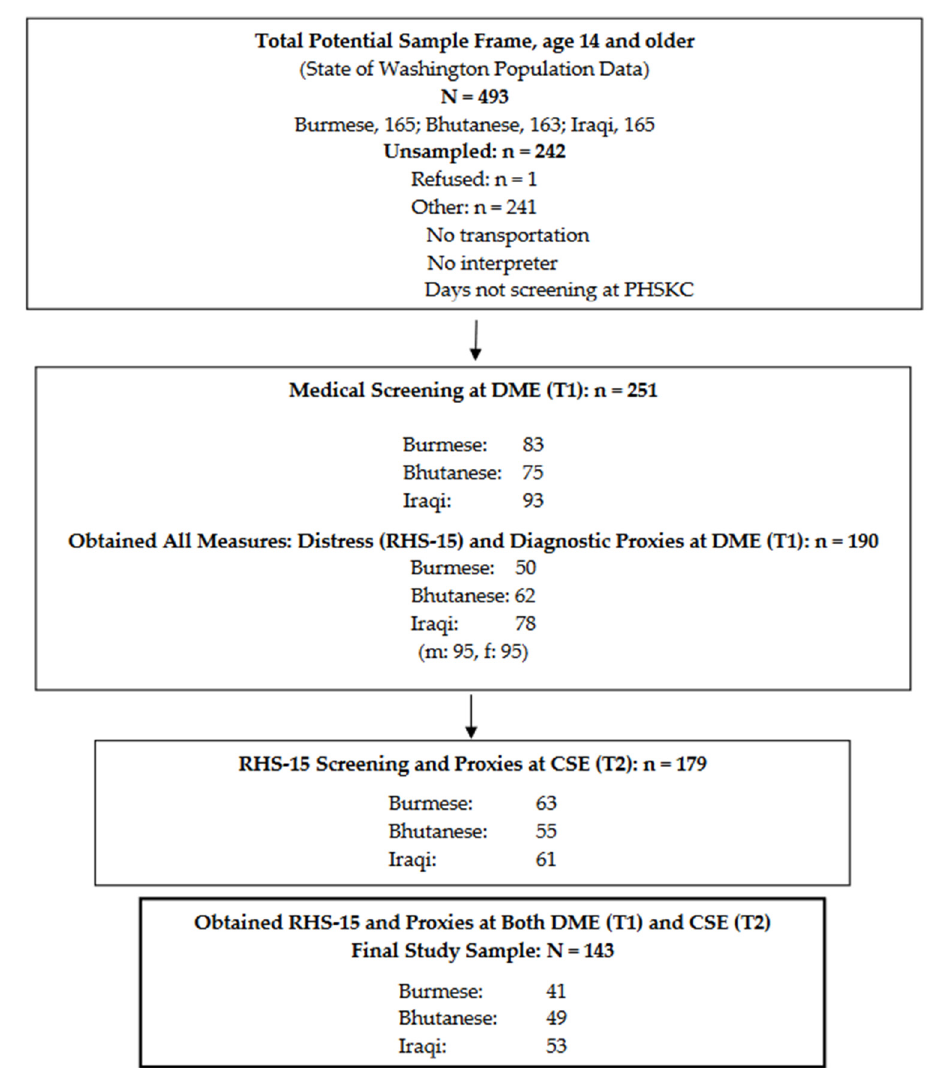
Figure 1. Sample Frame, Sample, and Subject Flow. Table 2. Distress trajectory by country of origin and